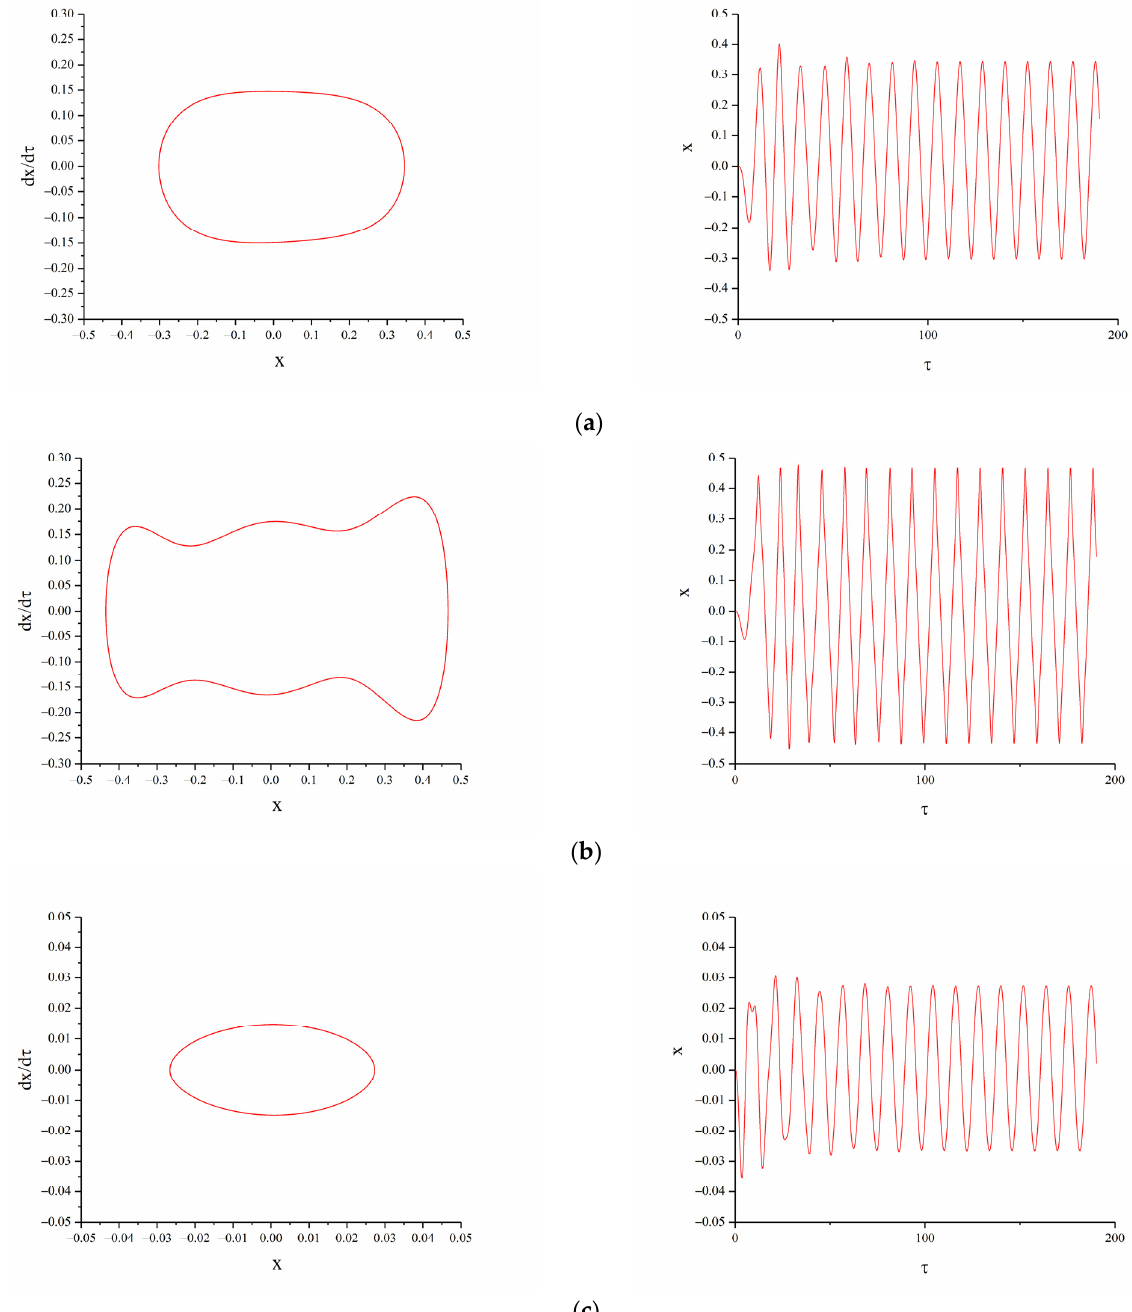
Figure 6. Phase portrait and time-displacement diagram of different magnetic distance 𝑑 : ( a ) 𝑑 = 22 mm ; ( b ) 𝑑 = 15 mm ; (c) 𝑑 = 13 mm .